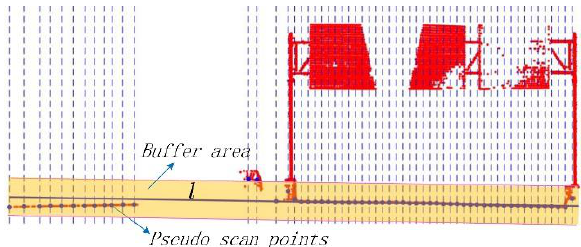
Figure 7. The extraction of the buffer area of the road